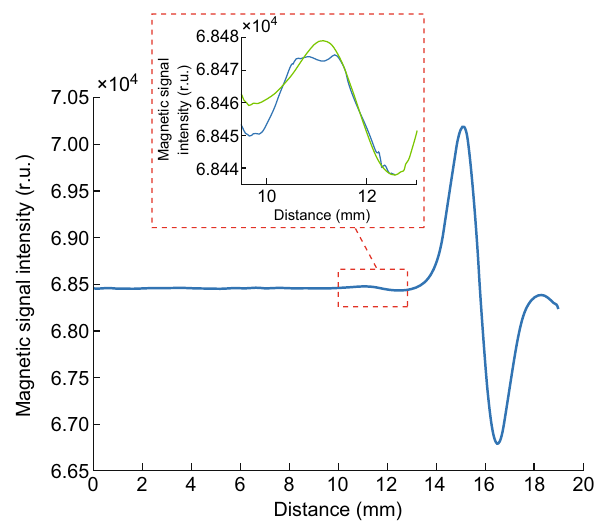
Fig. 7 Results of waveform reconstruction (in the small diagram). Blue line is the distorted waveform, and green line is the recon- structed waveform. (Color figure